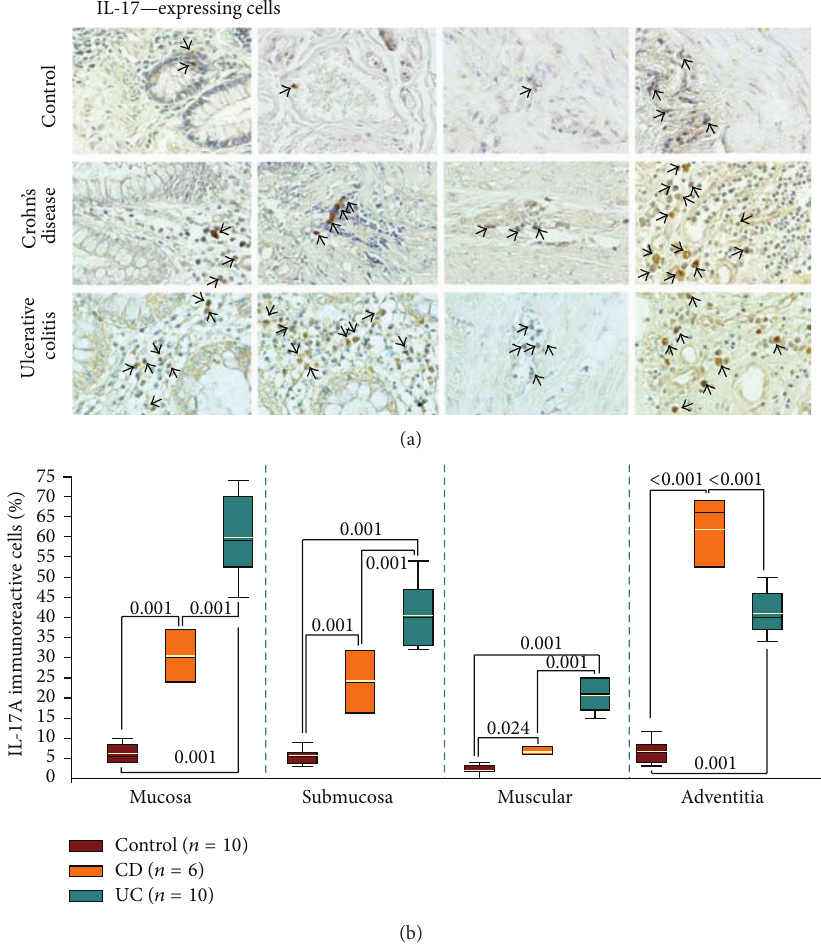
Figure 6: IL-17A-expressing cells in colonic mucosa from IBD (UC and CD) patients. (a) Representative immunoperoxidase of IL-17A expression in non-inflamed colonic tissue (upper panel), in tissue from an active CD patient (middle panel), and in colonic mucosa from an active UC patient (lower panel). From the left to the right photomicrographs represent mucosa, submucosa, muscular, and adventitia. Arrows depict immunoreactive positive cells (X320). (b) Bars indicate immunohistochemistry analysis of IL-17A-producing cells in non- inflamed colonic tissues, in tissues from active CD patients, and in colonic mucosa from active UC patients. Results are expressed as median (black line), 10th, 25th, 75th, and 90th percentiles. Yellow line represents the